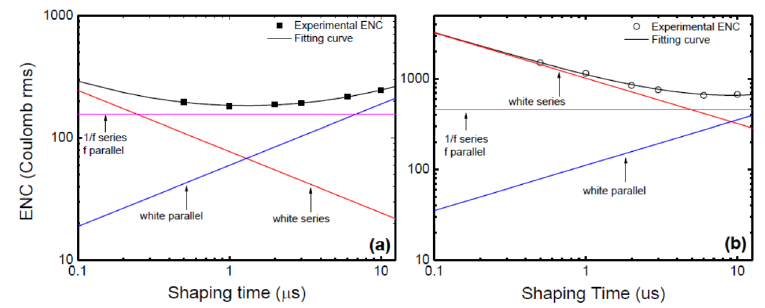
Figure 14. Variation of equivalent noise charge as a function of shaping time constant ( a ) without the detector connected, ( b ) with the detector connected.